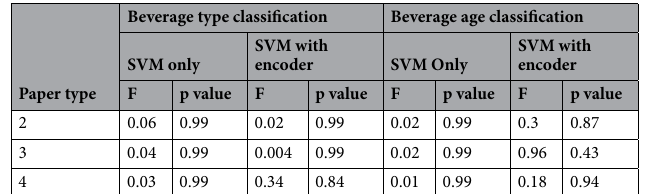
Table 2. ANOVA of the accuracies for k-fold results.